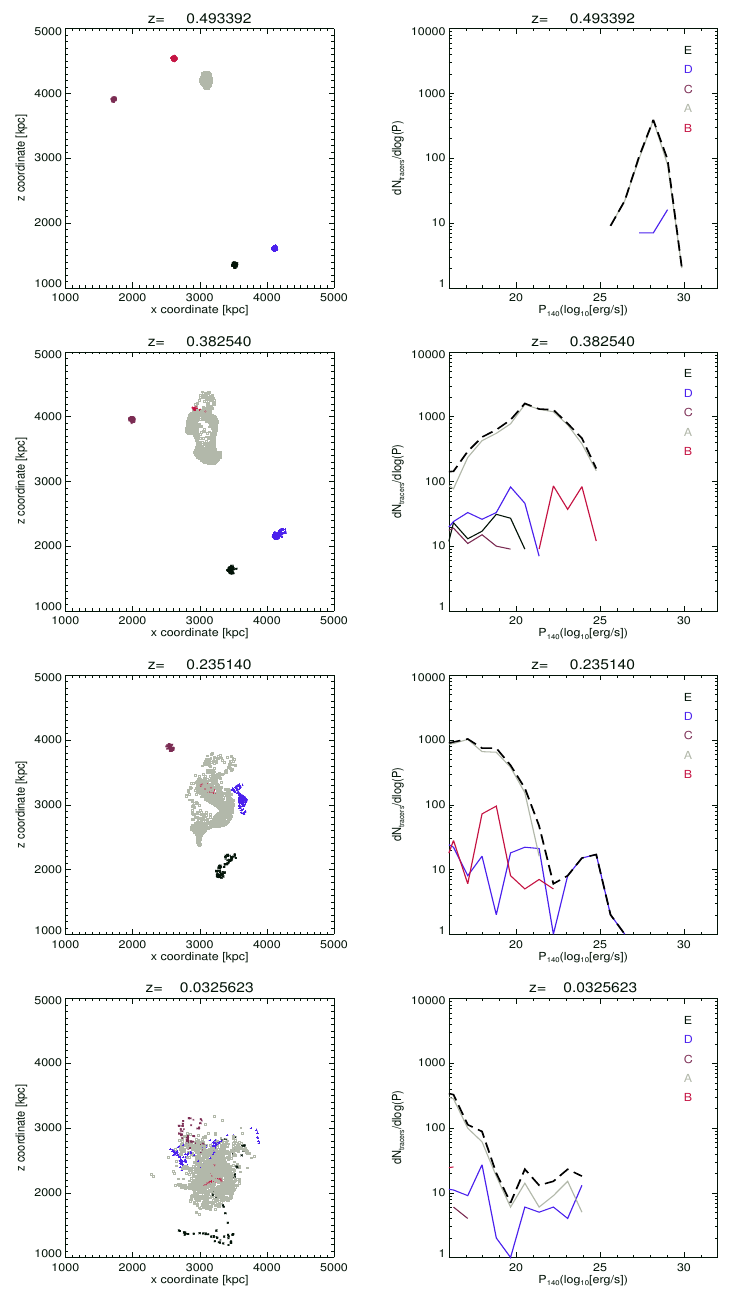
Figure 5. ( Left panels ): evolving projected location of simulated populations of relativistic electrons seeded by radio jets. ( Right panels ): distribution of radio emission power at 140 MHz for the corresponding families of tracers (in the CST model), and for their total (grey dashed